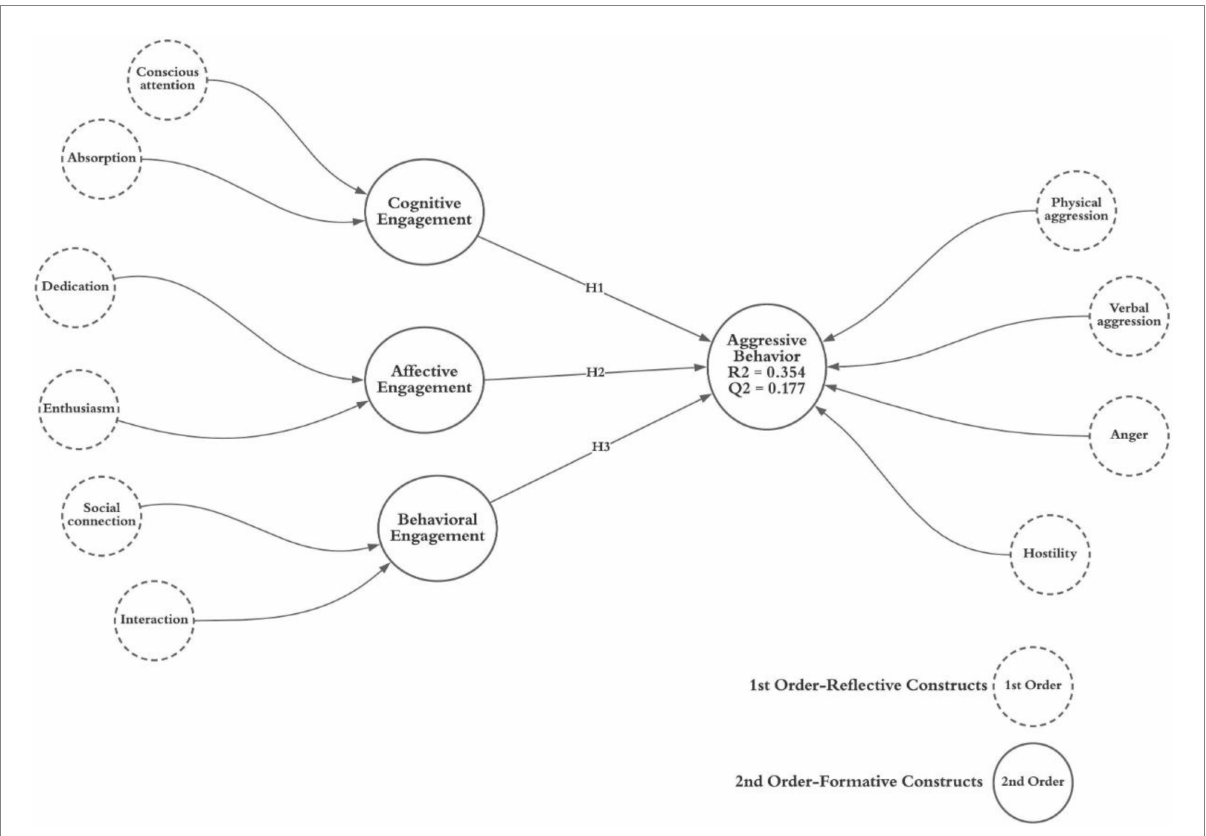
FIGURE 1 A conceptual